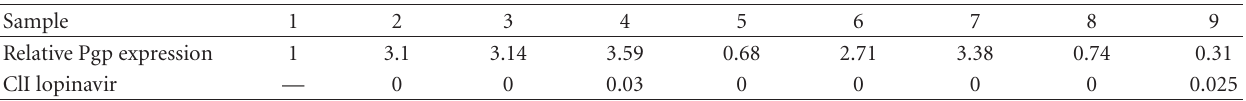
Table 2: Clearance index of lopinavir in the control phase (0–45 minutes) and Pgp placental expression for experiments during the control phase at physiological albumin concentrations (30–40g/L).